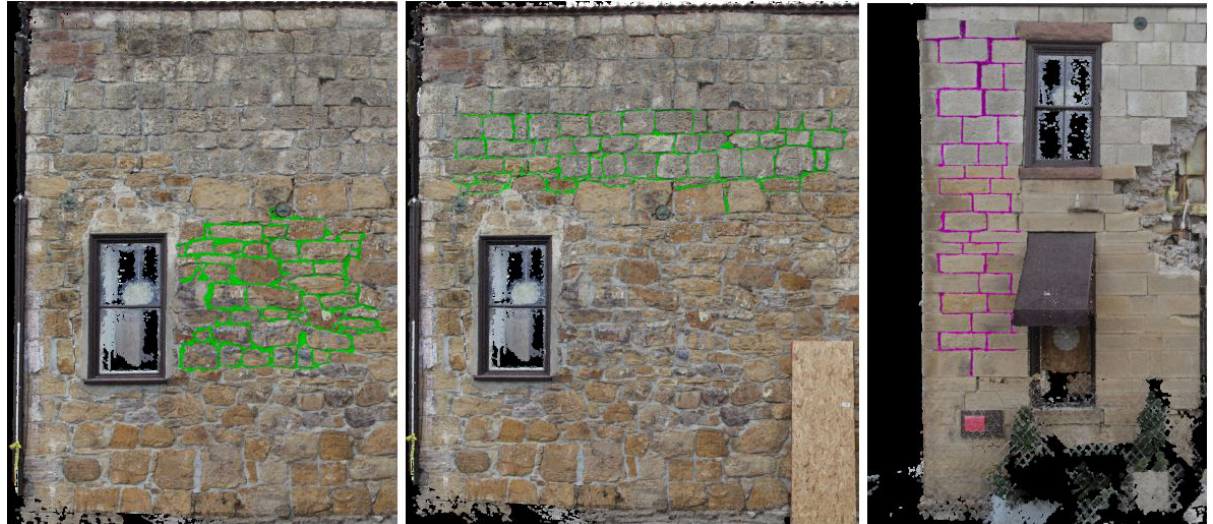
Figure 4. Example of the interactive annotation used on dense point cloud